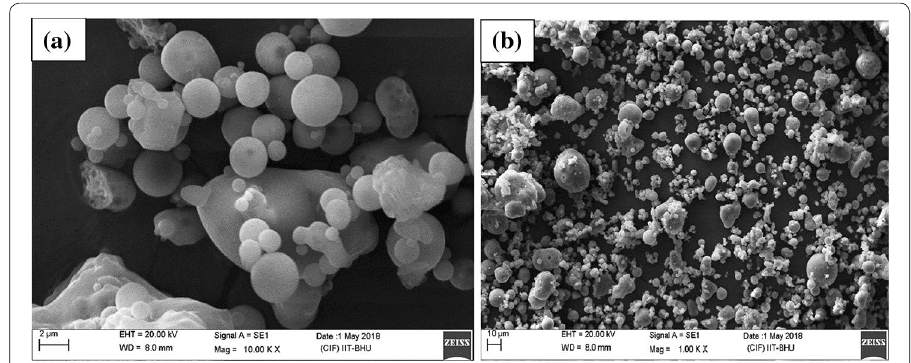
Fig. 9 SEM Micrograph for Borabanda MSW particle a 10.00Kx, b 1.00Kx